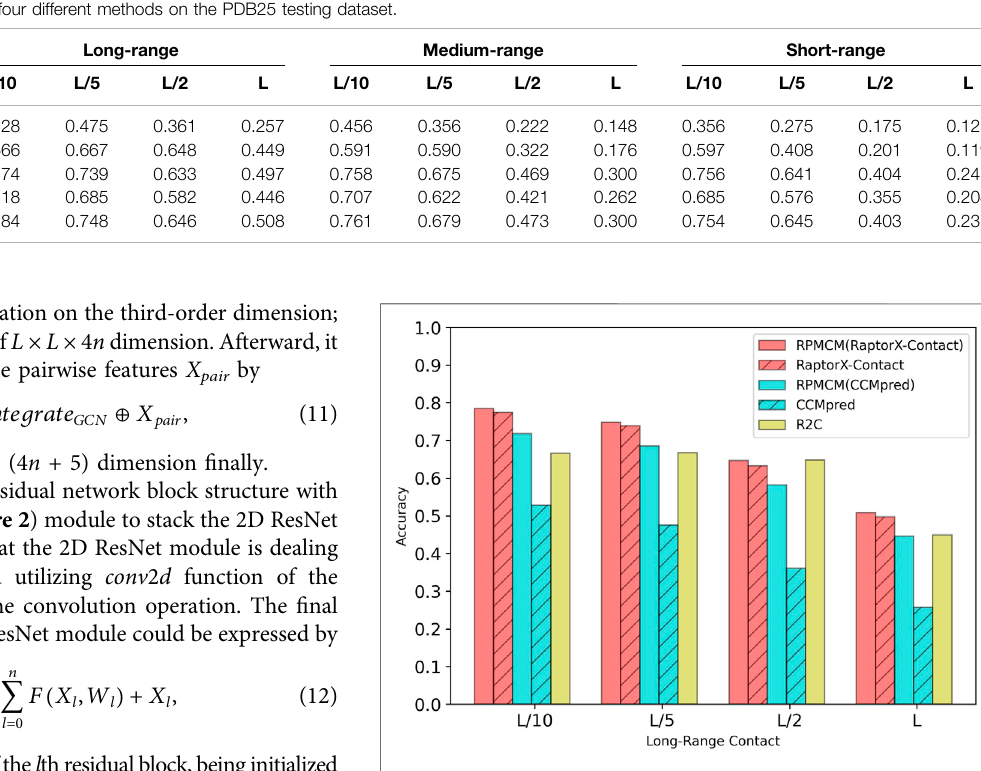
FIGURE 3| Comparison of method accuracy for the long-range contact on the PDB25 testing